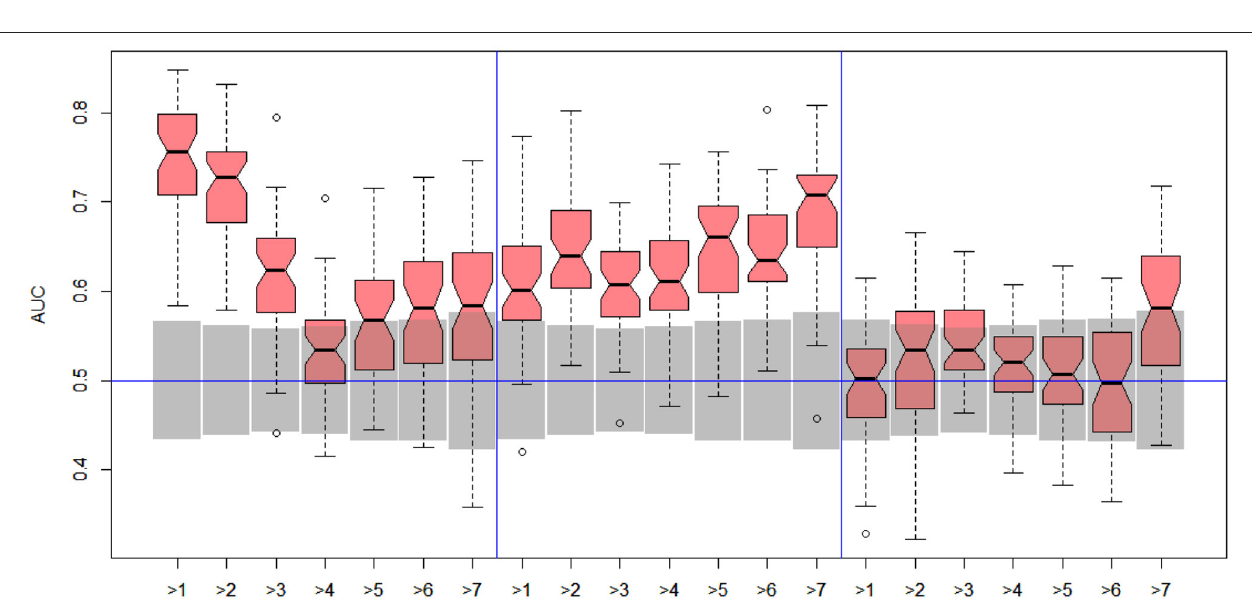
FIGURE 4 | DILI2 scanning results for A375 (left) , HEPG2 (middle) , and MCF7 (right) cell lines. Gray boxes correspond to 95% confidence interval for the null hypothesis.